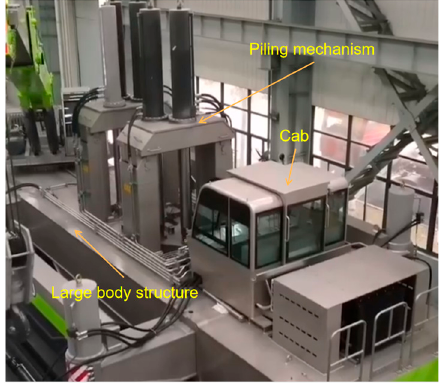
Figure 3. Hydraulic pile driving mechanism and